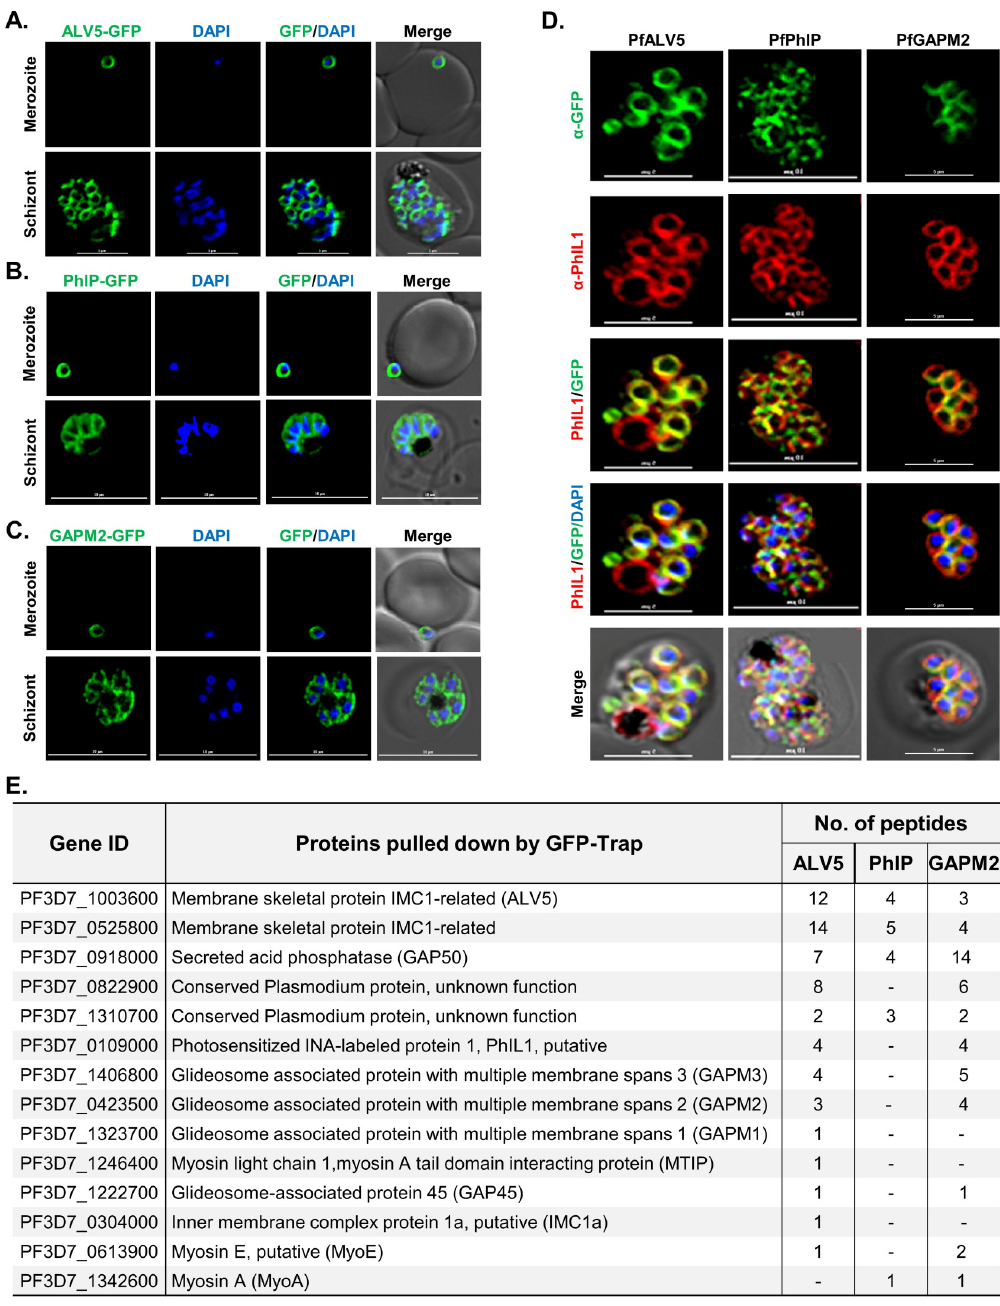
Fig 1. PhIL1 colocalize with ALV5, PhIP, and GAPM2 in the P . falciparum IMC. (A) ALV5-GFP expression pattern in asexual blood stages (merozoite, and schizont) of P . falciparum . (B) PhIP-GFP expression pattern in asexual blood stages showed typical IMC localization. (C) GAPM2-GFP expression pattern in asexual blood stages. (D) Co-staining of PhIL1 with ALV5, PhIP, and GAPM2 in P . falciparum blood-stage schizont. These proteins co-localized with PhIL1 in the IMC at the schizont stage of the parasite with a Pearson’s colocalization coefficient of more than 0.7. Scale bar = 5 μ m. (E) List of proteins pulled down by GFP-trap beads from lysates obtained from parasites expressing GFP-tagged ALV5, PhIP, or GAPM2 respectively. n = 3